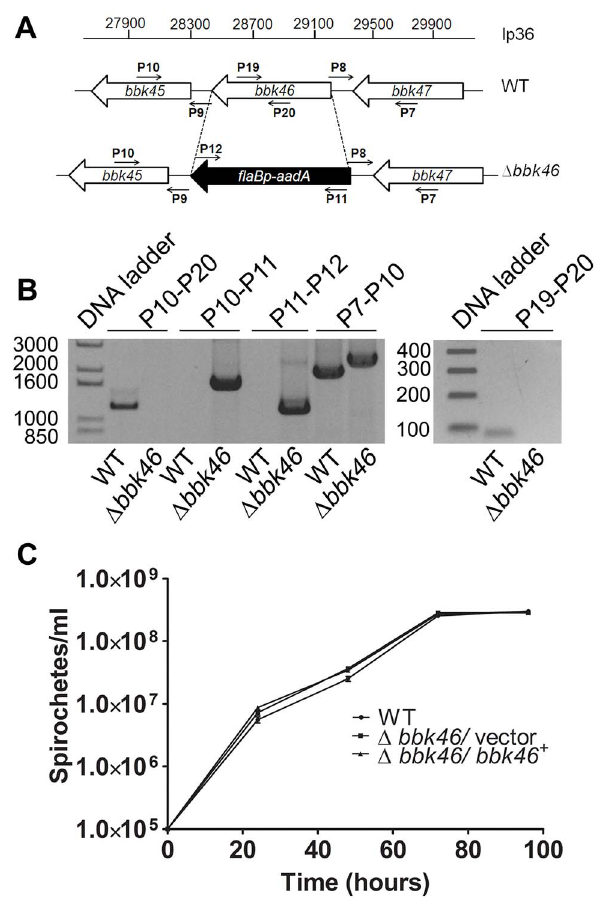
Figure 5. Generation of the D bbk46 mutant and genetic complemented clones in B.burgdorferi . (A) Schematic representa- tion of the wild-type (WT) and D bbk46 loci on lp36. The sequence of the entire bbk46 open reading frame was replaced with a flaB p - aadA antibiotic resistance cassette [37,82]. Locations of primers for analysis of the mutant clones are indicated with small arrows and labels P7-P12, P19 and P20. Primer sequences are listed in Table 5. (B) PCR analysis of the D bbk46 mutant clone. Genomic DNA isolated from WT and D bbk46/ vector spirochetes served as the template DNA for PCR analyses. DNA templates are indicated across the bottom of the gel image. The primer